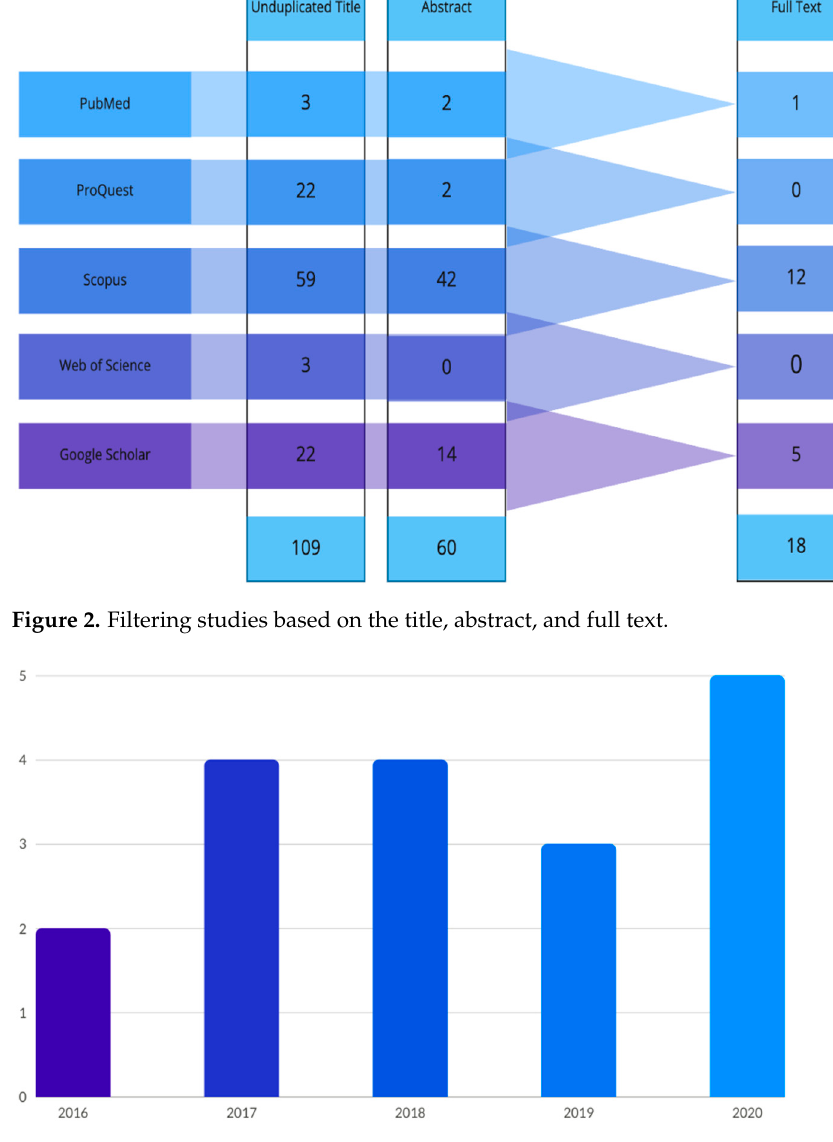
Figure 3. Studies’ publication years.